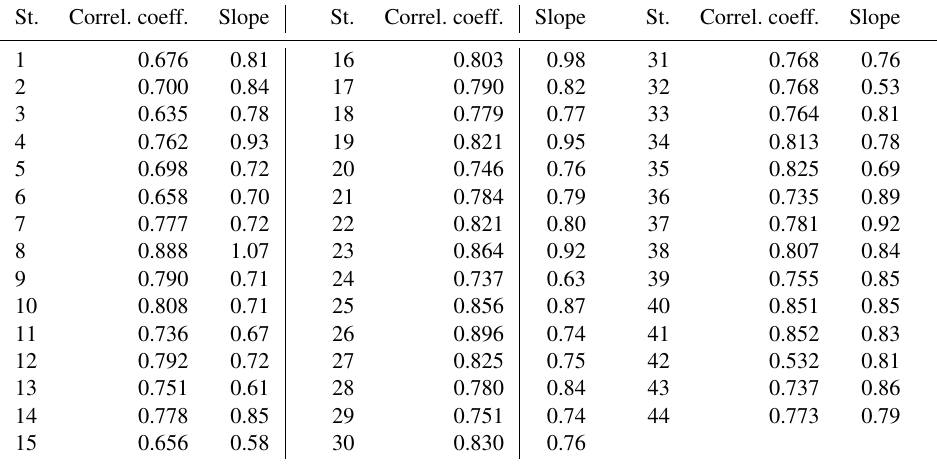
Table 9. Correlation coefficients (Correl. coeff.) and slopes of the least-squares fitting lines at each station for B N . St. Correl. coeff. Slope St. Correl. coeff. Slope St. Correl. coeff.